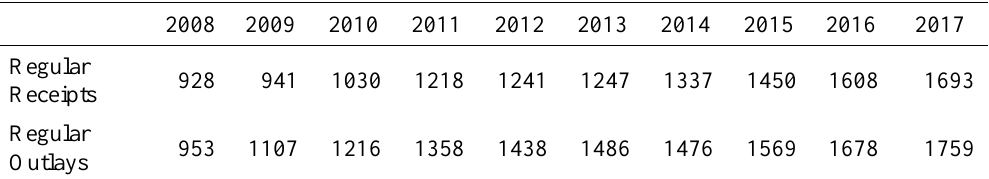
Table 5. Regular Budget Deficit (millions of